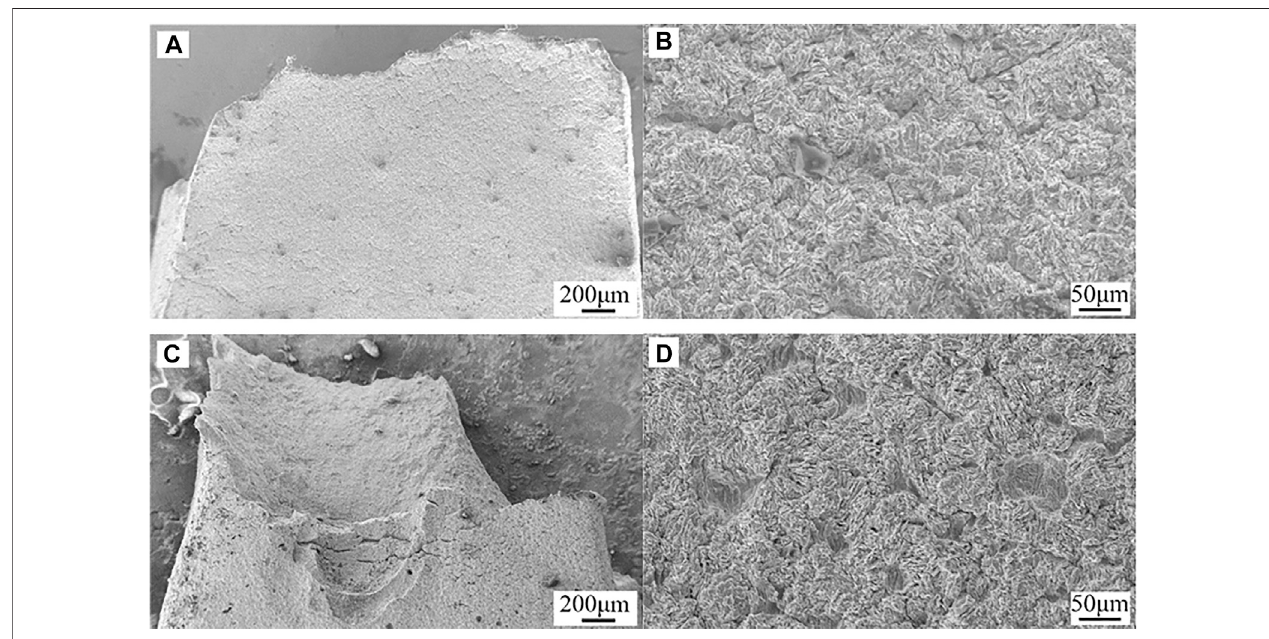
FIGURE10| FracturemorphologiesofHP-13CrSSafterLAimmersionandSSRTintheFWviewedfromthetransverseat95 ° C/2.8MPaCO 2 (A) lowmagni fi cation and (B) high magni fi cation and 120 ° C/3.2 MPa CO 2 (C) low magni fi cation and (D) high magni fi cation.